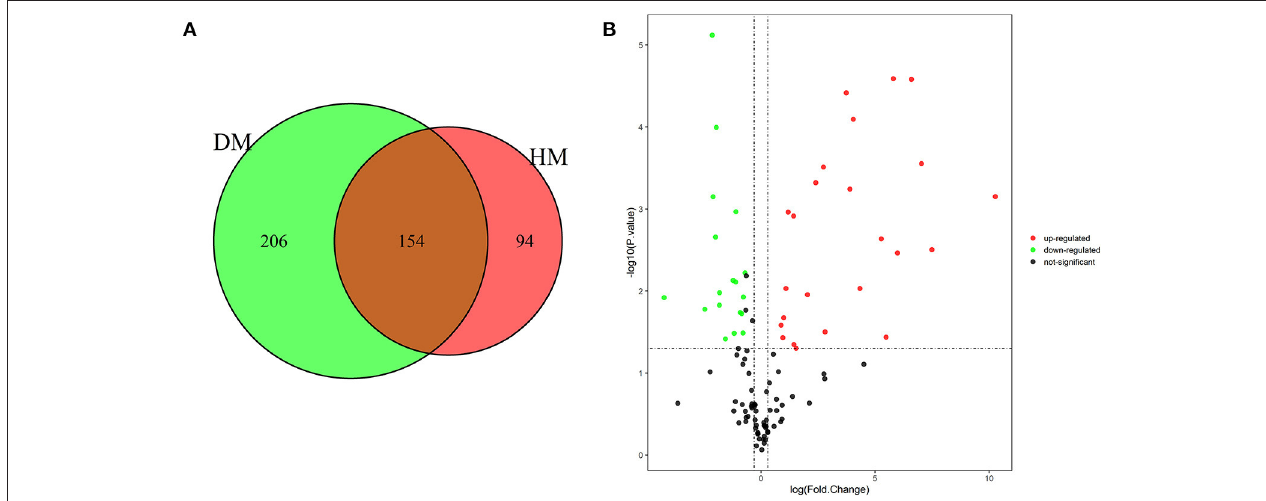
FIGURE 1 | Venn diagram of MFGM proteins identified from DM and HM group (A ); Volcano plot of proteins identified from DM and HM group (B) . Red dot, up-regulated proteins in DM and HM MFGM; Green dot, up-regulated proteins in DM and HM MFGM; Black dot, not significant different proteins between DM and HM. MFGM, milk fat ball membrane; DM, donkey milk; HM, human milk.